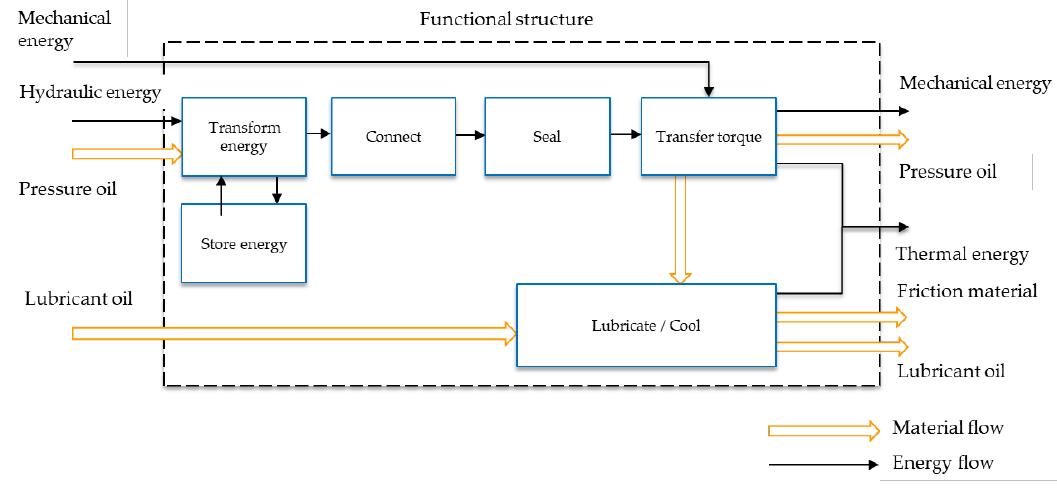
Figure 4. Function structure of a transmission clutch.